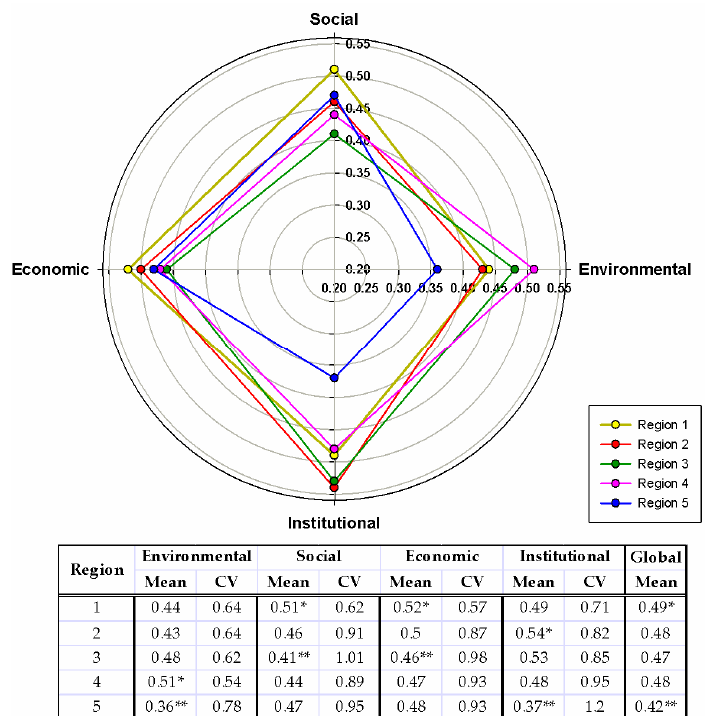
Figure 5. Average and variation coefficient of normalized values by subsystem and region. CV: Coefficient of variation. * Best region, ** Worst